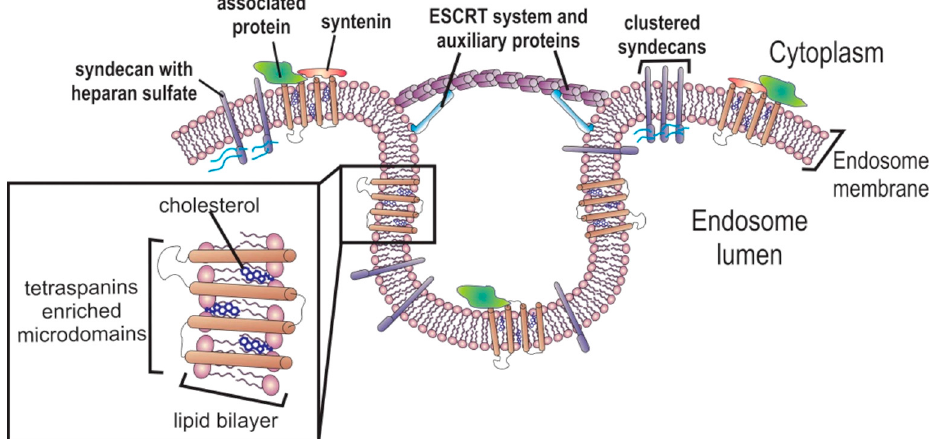
Figure 2. Active protein sorting into Intraluminal vesicles. During the intraluminal vesicles formation in the endosomes, proteins are sorted by the heparanase-syntenin-ALIX-ESCRT mechanism. Syndecans with long heparan sulfate chains are trimmed by heparanase and clustered after proteolytic cleavage. Syntenin couples to endosomal sorting complexes required for transport (ESCRT) machinery via Alix protein, then recruits the clustered syndecans with associated proteins and growth factors. Proteins associated with tetraspanin-enriched microdomains are probably inserted in ILVs via CD63, which is also recruited by syntenin [49].